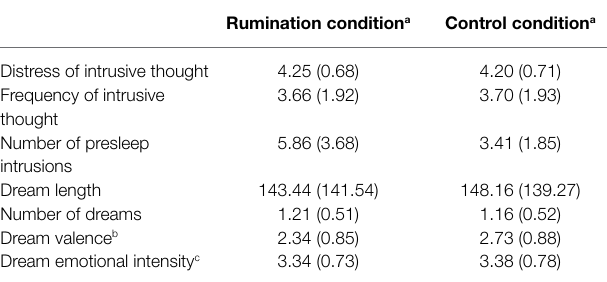
TABLE 1 | Mean (SD) participant characteristics, ratings of target thought, and ratings of dream content.